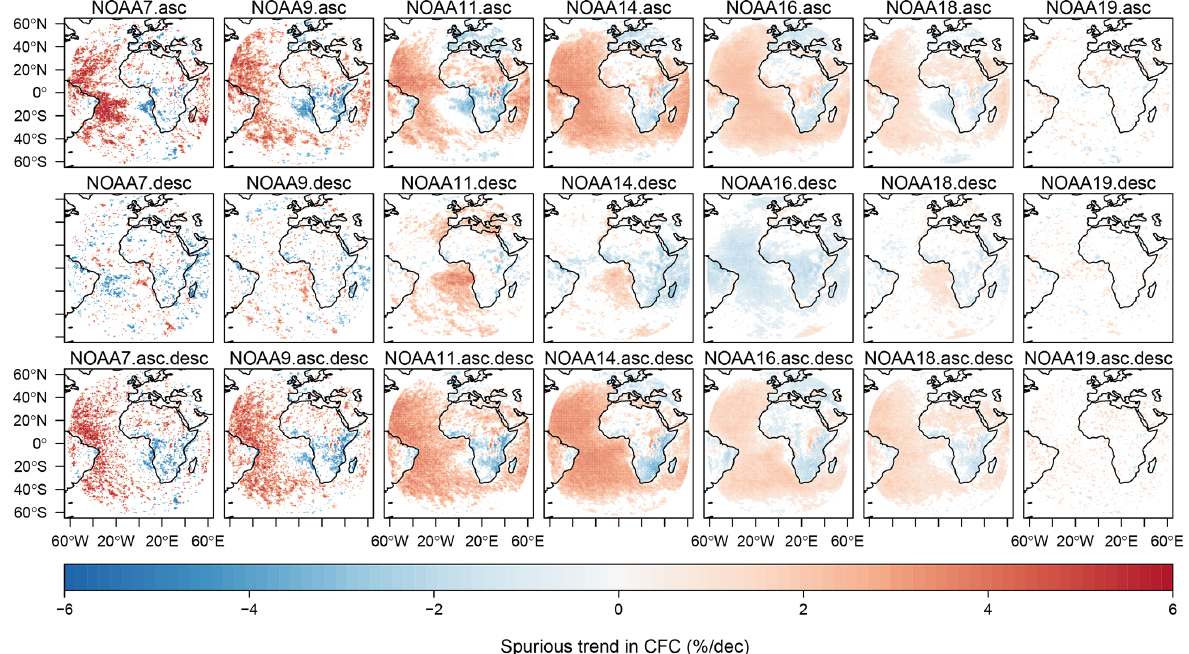
Figure 11. Spurious trends in CFC caused by orbital drift presented for each afternoon (PM) NOAA satellite and each node (asc – ascending, desc – descending, and asc.desc – ascending and descending combined). Only statistically significant trends are shown.